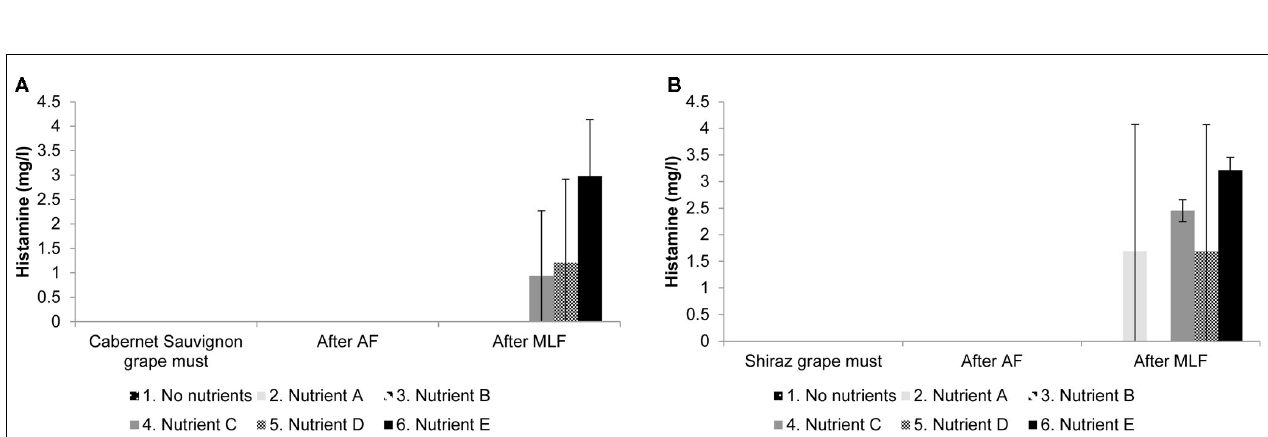
FIGURE 3 | Histamine production in (A) Cabernet Sauvignon and (B) Shiraz wines supplemented with complex yeast or bacterial nutrients. Results are the average of duplicate treatments.